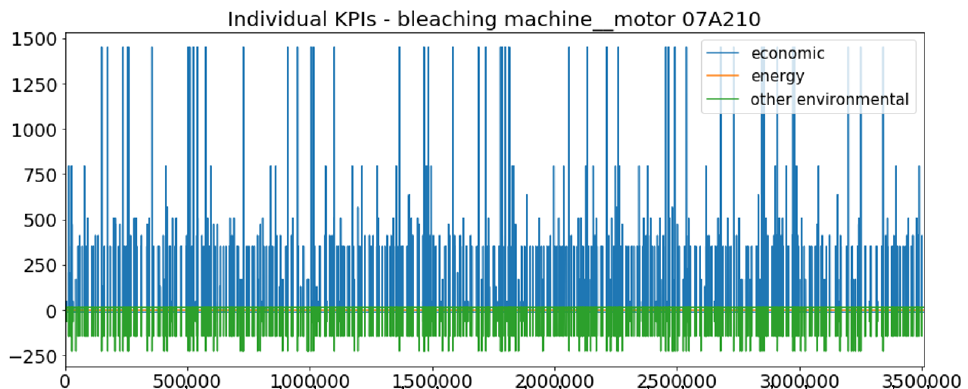
Figure 19. Individual KPI time series for the motor yielded from running the model with paired coated rollers for the bleaching machine (ZORLUTEKS). The simulation interval has the same length as for training (200 years).